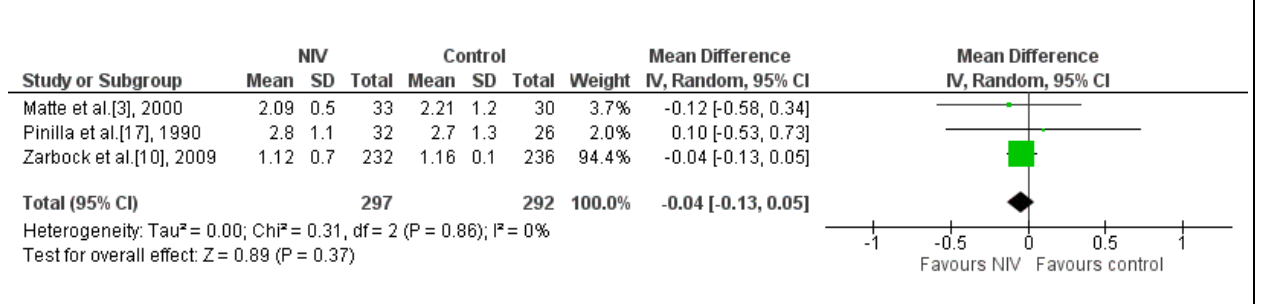
Fig. 5 – Analysis of the time spent in the intensive care unit regarding the studies that compared the prophylactic NIV to the control group. NIV=noninvasive ventilation